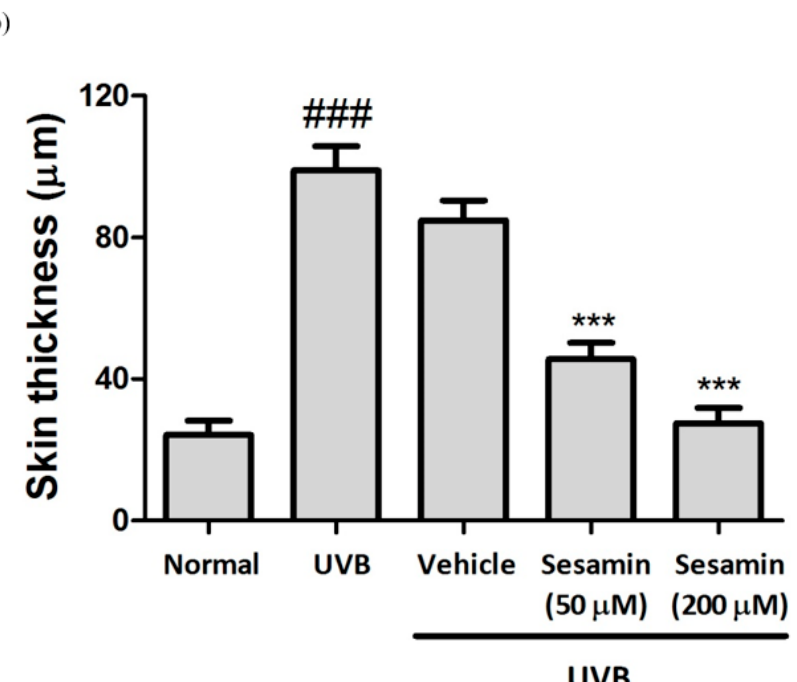
Figure 16. E ff ect of sesamin on skin thickness in chronic UVB-irradiation hairless mice. ( a ) Light micrographs of histological sections stained with hematoxylin and eosin (H&E); and ( b ) e ff ect of sesamin on skin thickness in chronic UVB-irradiation hairless mice at the 10th week. Significant di ff erence versus normal group: ### p < 0.001. Significant di ff erence versus UVB group: *** p < 0.001.